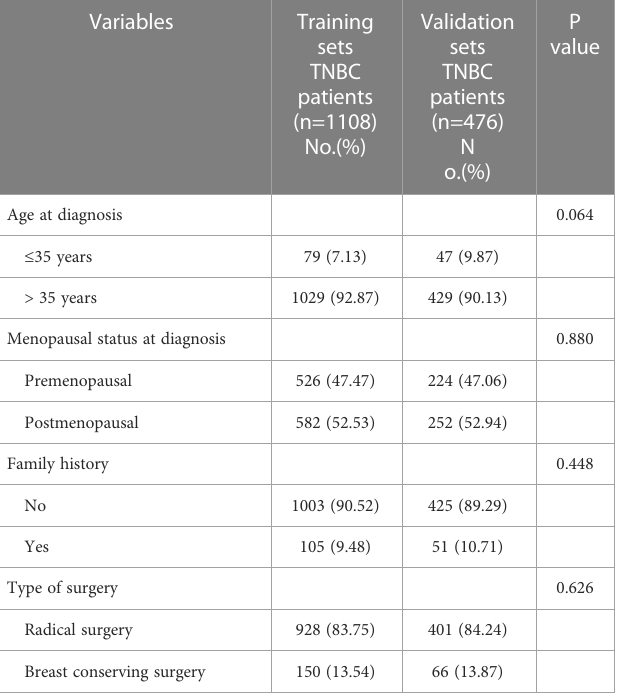
TABLE 2 Clinicopathological parameters of TNBC patients in the training and validation